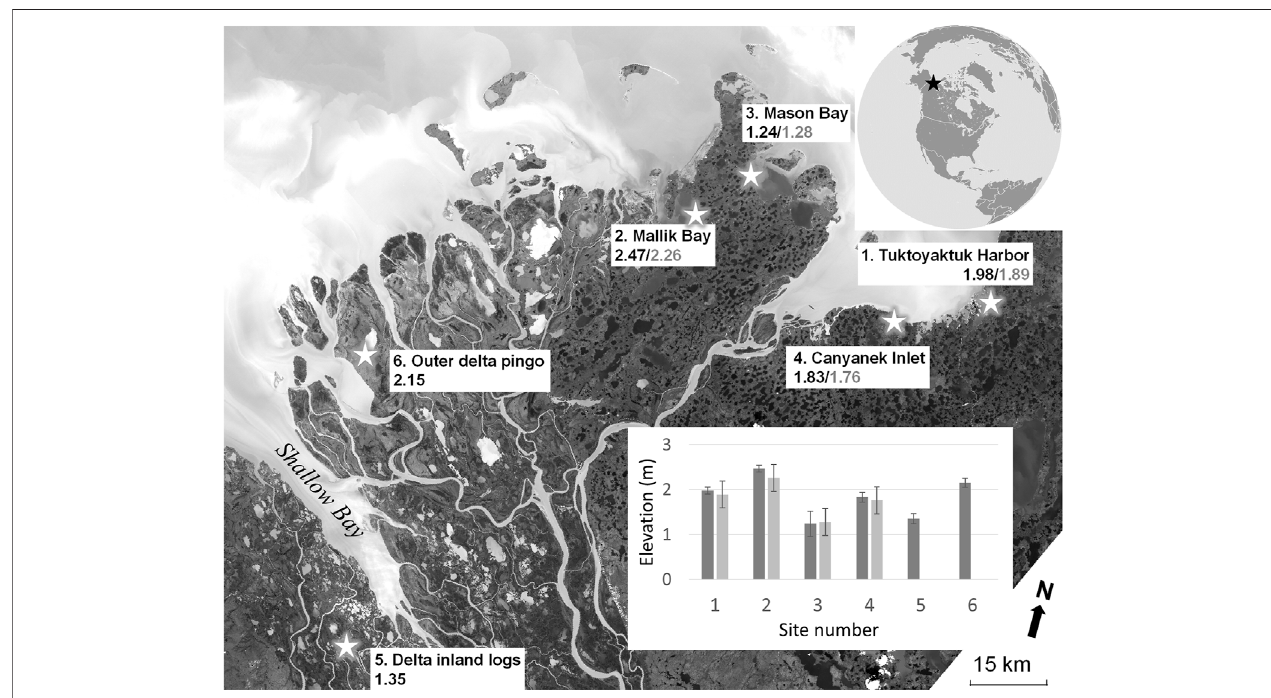
FIGURE1| Mapshowingthelocationofstudysites.ElevationsoftheupperdriftwoodfoundateachsitebyHarperetal.(1988)arewritteningrayandthosebythis study in black. All elevations are reported in meters and in reference to the CGVD2013 vertical datum. The inset graph indicates the elevations and total accumulated errorbarsinmeasurementsfromthisstudyateachsite(darkboxes)alongsideHarper etal.(1988)estimated totalerrorof0.38 minsurgeelevations(lightergreyboxes).